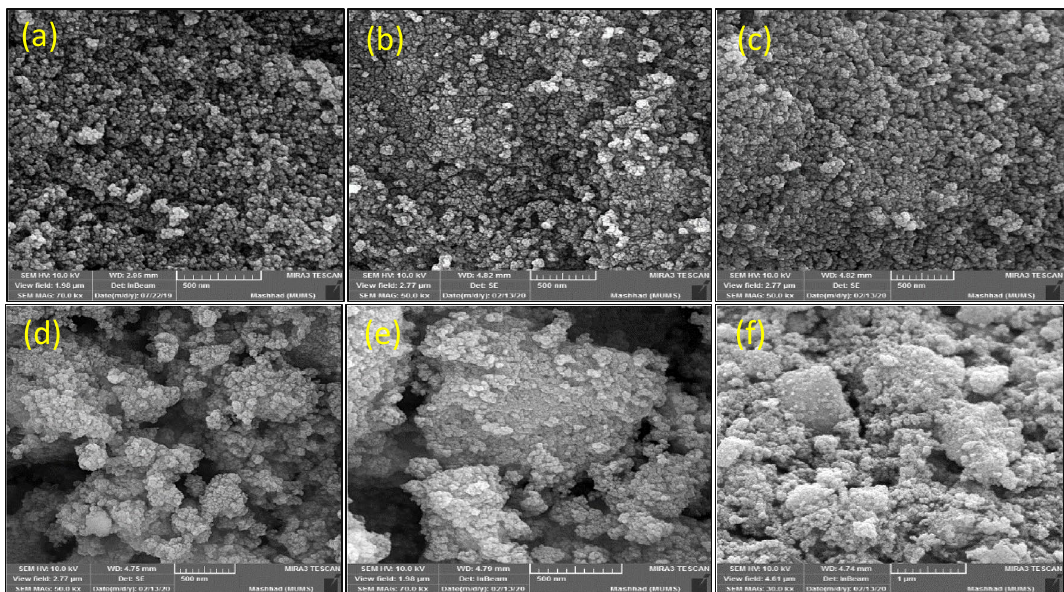
Figure 6. Field emission scanning electron microscopy pictures of the ( a ) γ–Fe 2 O 3 , (b) γ-Fe 2 O 3 @PEG, ( c )